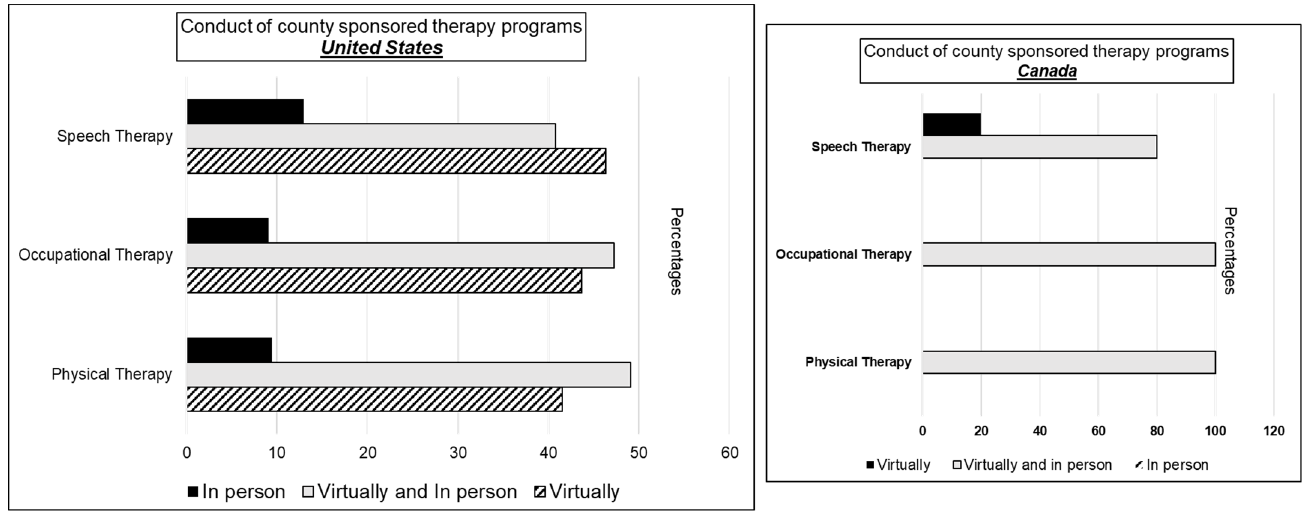
Figure 4. Conduct of government-funded therapy programs.